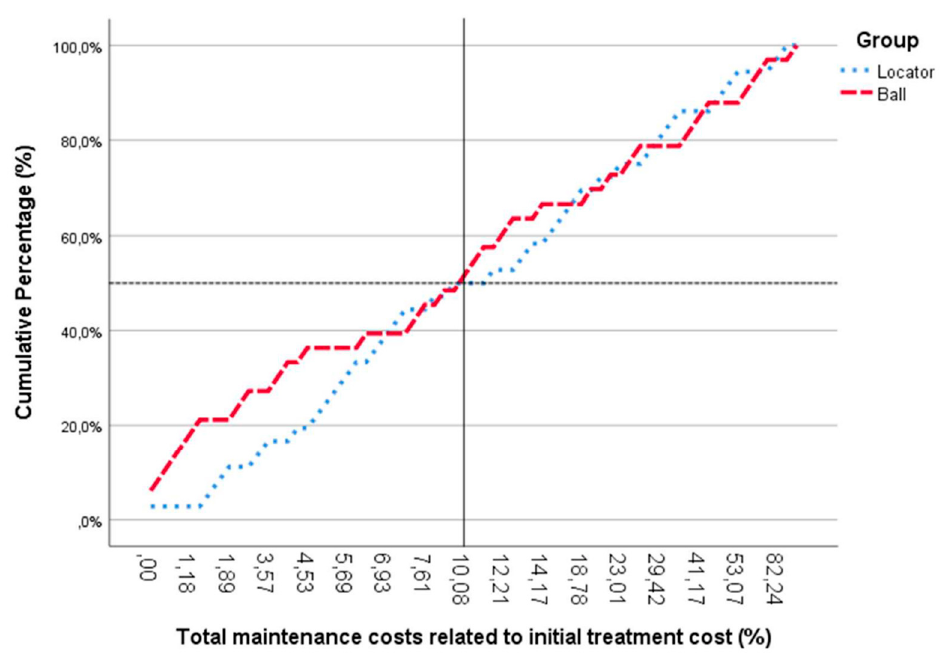
Figure 5. Cumulative percentage of maintenance costs compared to the initial treatment cost. For 50% of the total population, the amount of total maintenance cost is around 10% compared to the initial cost.